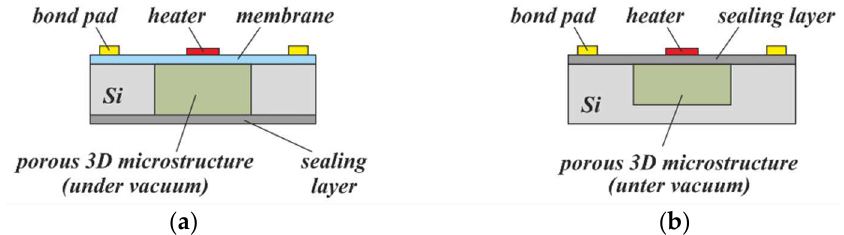
Figure 17. Concepts for the thermal insulation of calorimetric MEMS devices using porous 3D microstructures under vacuum: In ( a ) the 3D microstructure is post-processed within the backside cavity of a finished, membrane-based device and, finally, sealed under vacuum. In ( b ), the 3D microstructure is pre-processed including planarization and sealing under vacuum. Subsequently, the MEMS device is processed on top. Please note that in both cross-sections the electrical wiring from the heater to the bond pads is not shown.